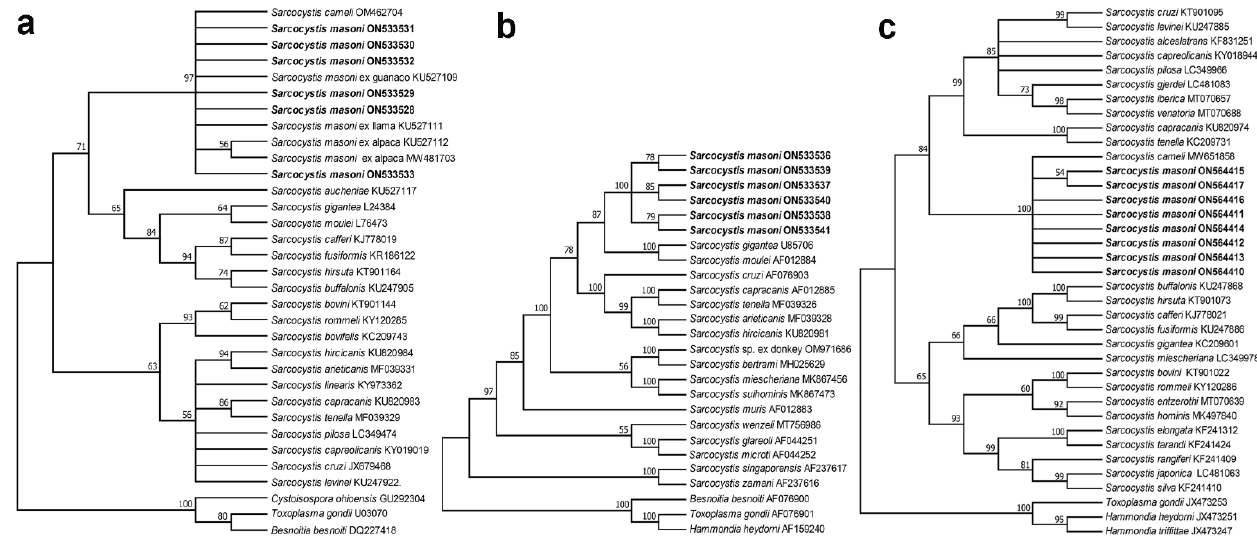
7 of 10 Figure 3. Results of PCR with primers SF1/SR9 and restriction enzyme digestion with ClaI and AvaII of sarcocyst and oocyst DNA from Sarcocystis masoni . M, molecular mass marker; Sms, S . masoni sarcocyst; Smo, S . masoni oocyst; P, PCR product; D, digestion of PCR product with ClaI and AvaII. 3.5. Phylogenetic Analysis Phylogenetic analysis based on the 18S rDNA, 28S rDNA, and mitochondrial cox 1 sequences of S . masoni confirmed their association with Sarcocystis species (Figure 4). In